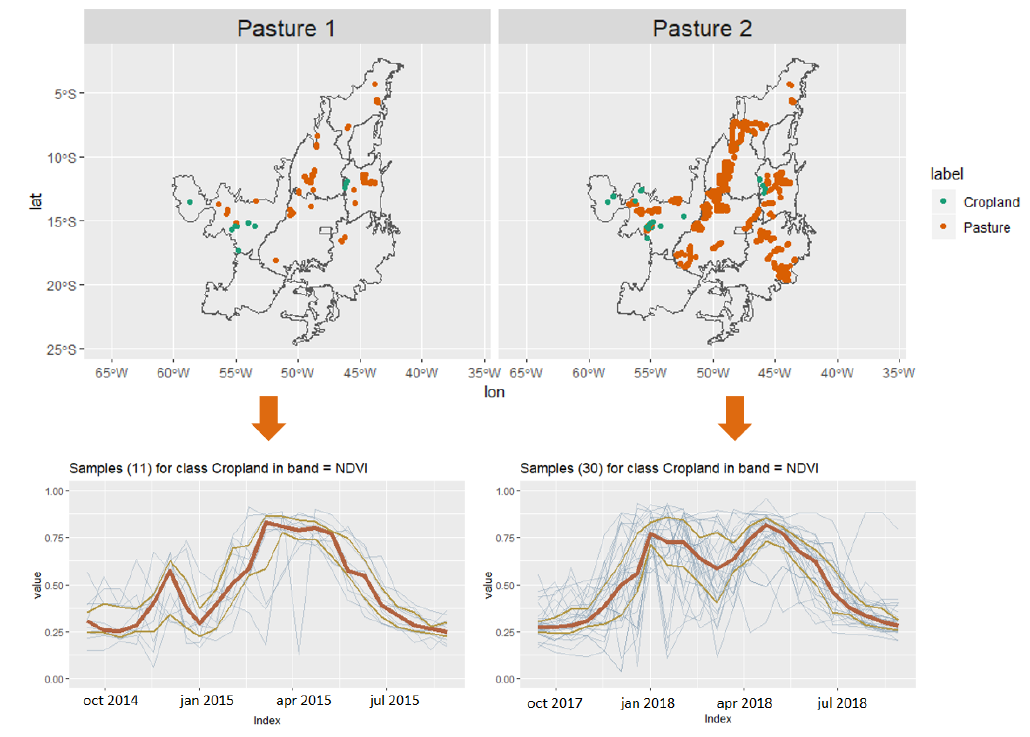
Figure 14. Samples originally labeled as cropland that were assigned to clusters of